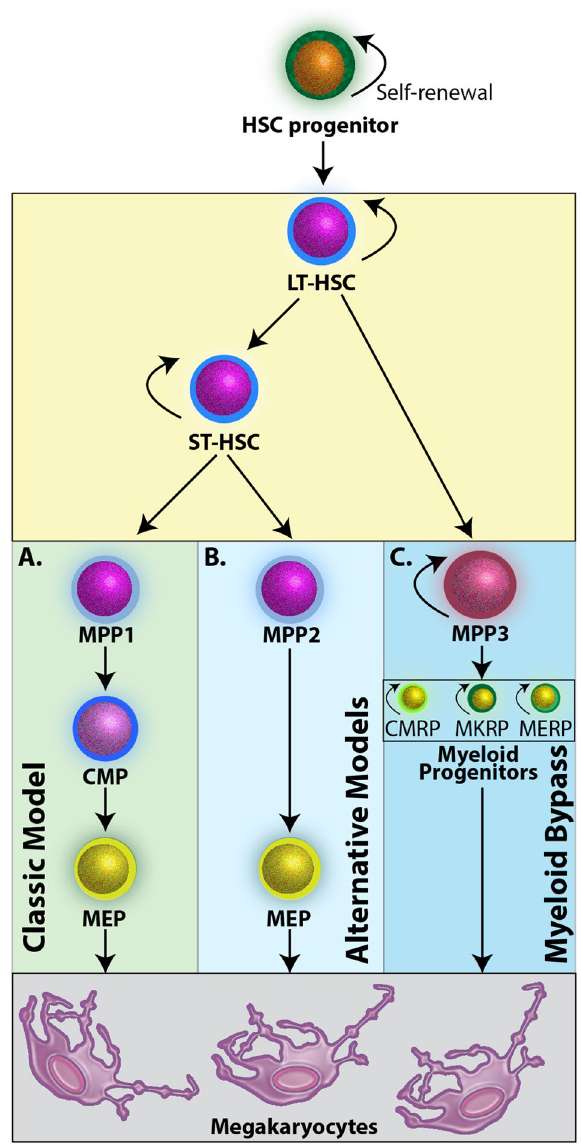
Figure 1. Models of MK differentiation from HSCs. ( A ) In the classic model, cell-fate decisions progress in a step-wise fashion where ST-HSCs differentiate toward an MPP1 cell population that has no self-renewal capacity but can further commit to CMP cells, MEP cells, and finally MKs. ( B ) The alternative model yields MEP cells directly from a non-self-renewing MPP2 cell type. ( C ) The myeloid bypass model suggests that LT-HSCs are primed to directly give rise to an MPP3 cell type capable of producing myeloid progenitor populations that all have the capacity to self-renew and maintain specific cell populations. HSC hematopoietic stem cell; LT-HSC long-term hematopoietic stem cell; ST-HSC short-term hematopoietic stem cell; MPP multipotent progenitor; CMP common myeloid progenitor; MEP megakaryocyte/erythroid progenitor; MK megakaryocyte; CMRP common myeloid repopulating progenitor; MKRP megakaryocyte repopulating progenitor; MERP megakaryocyte-erythroid repopulating